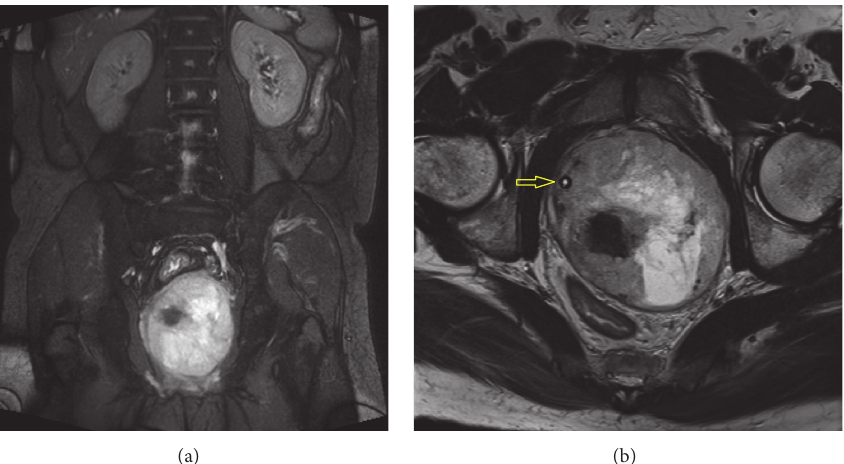
Figure 1: Prostate MRI with coronal (a) and axial (b) views showing marked enlargement of prostate gland with architecture derangement. Urethra with Foley ( arrow ) was shifted to the right side.